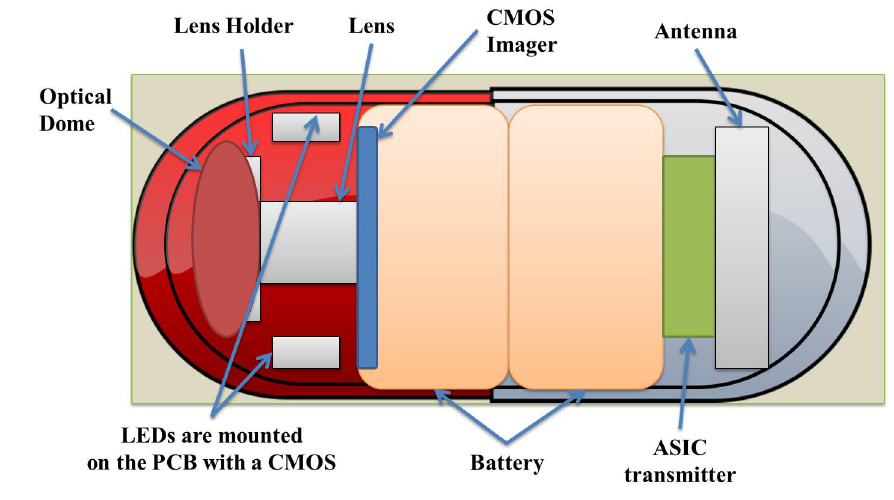
Figure 2. Structure of a typical wireless endoscopic capsule (WCE), based on the architecture of the M2A